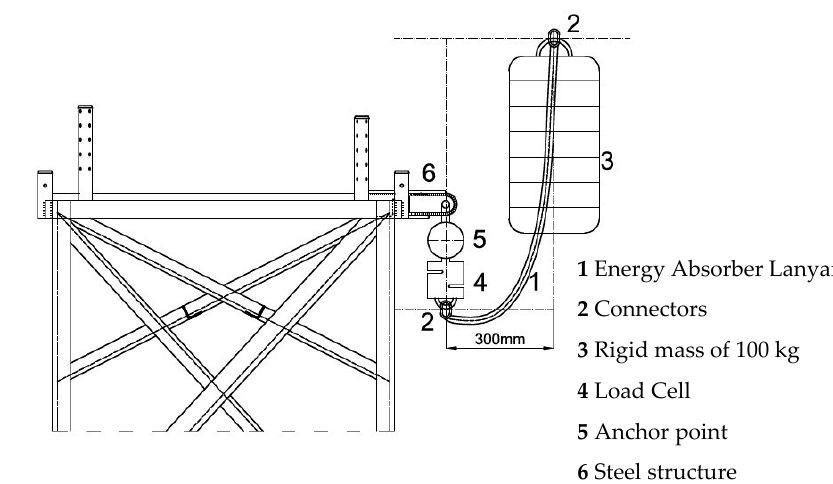
Figure 6. Dynamic behavior testing procedure.